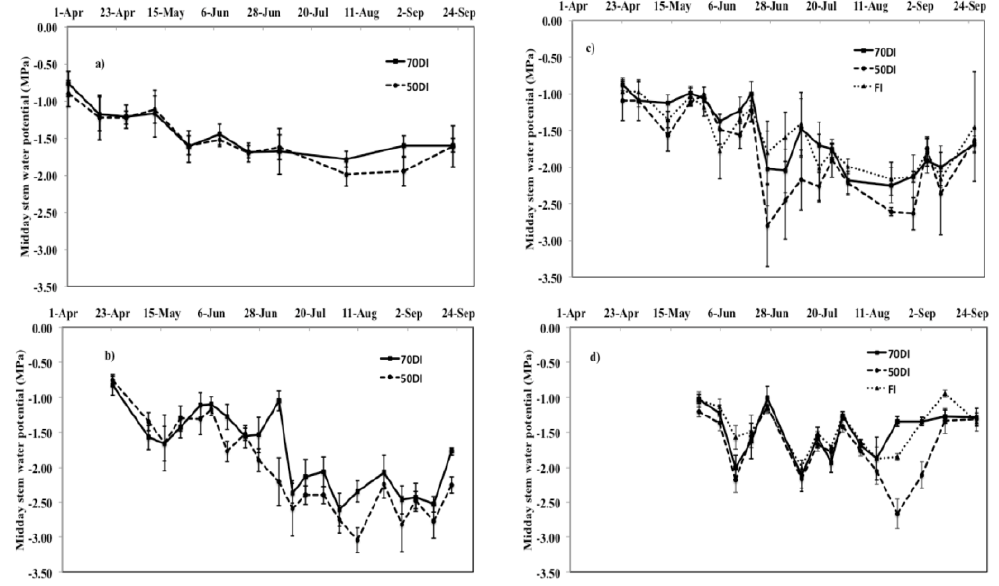
Figure 3. Midday stem water potential obtained with the pressure chamber for: ( a ) 2011, in DI treatments; ( b ) 2012, in DI treatments; ( c ) 2013, in all irrigation treatments; ( d ) 2014, in all irrigation treatments.